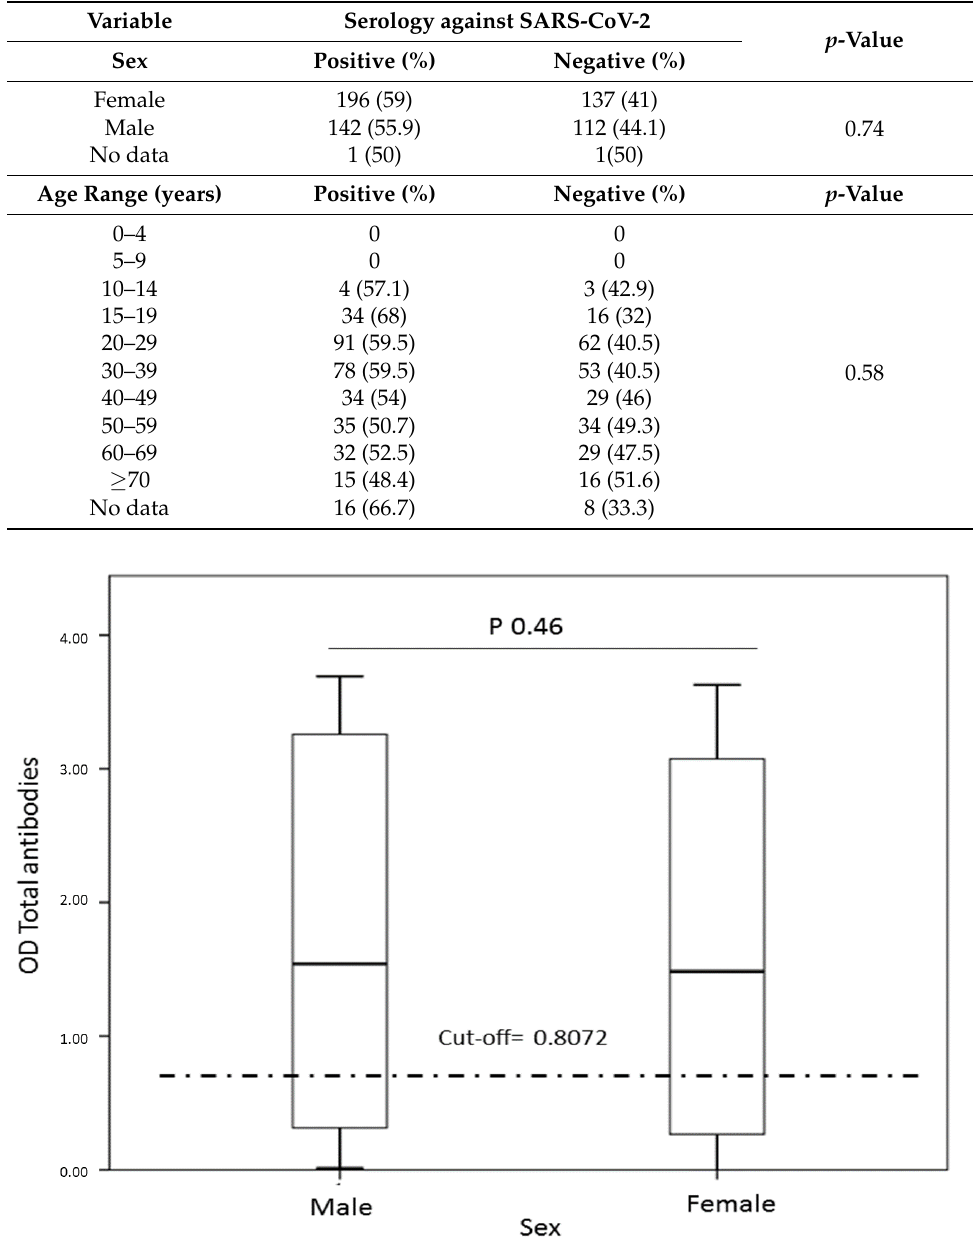
Figure 2. Relationship between sex versus serological data for SARS-CoV-2. A box made up of the 25th, 50th percentiles (median) is observed; 75th and extreme values represent outliers. There is no difference in seropositivity or OD of total antibodies against SARS-CoV-2 between men and women. More than 50% of the data is well above the cut-off. Relationship between seropositivity and age ranges. There were no differences be- tween the percentage of SARS-CoV-2 infection in the different age groups ( p > 0.05) (Table 2, Figure 3). Except for the group ≥ 70 years, all the population groups presented seroposi- tivity > 50%.